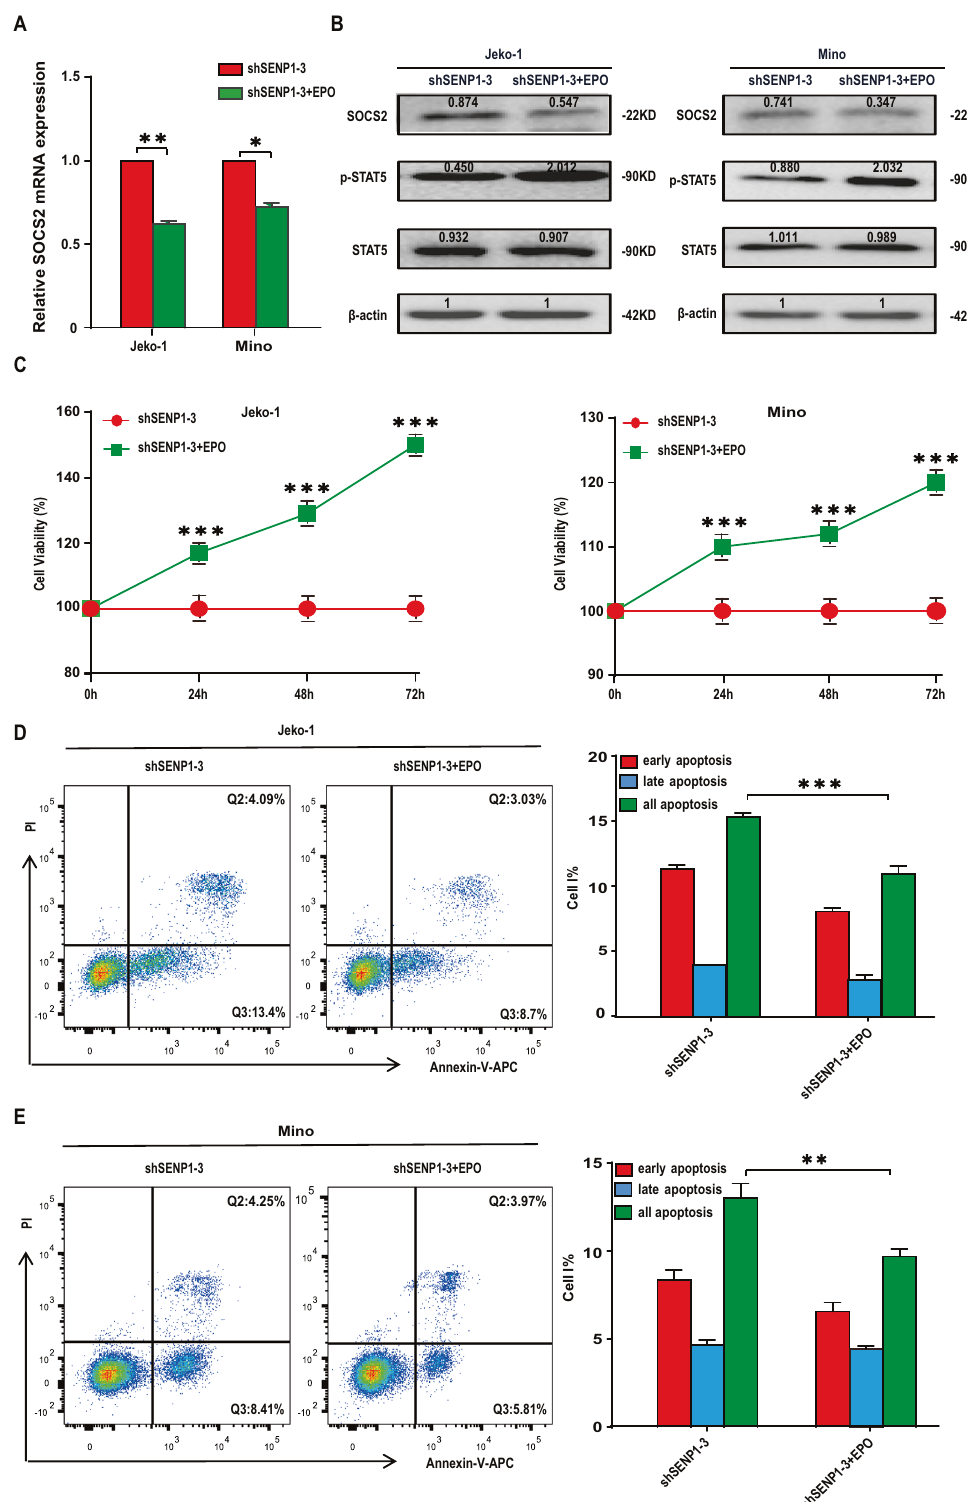
Fig. 5 Erythropoietin (EPO) rescues the effect of SENP1 knockdown on MCL cells. SOCS2 mRNA levels were detected by RT-qPCR ( A ), and the protein levels of SOCS2, p-STAT5 and STAT5 were detected by western blot ( B ) in shSENP1-3 transfected Jeko-1 and Mino cells after treated with EPO for 24 h. C The proliferation of shSENP1-3 transfected Jeko-1 and Mino cells was determined by CCK8 array after treated with EPO for 0 h, 24 h, 48 h or 72 h. The apoptosis of shSENP1-3 transfected Jeko-1 ( D ) and Mino ( E ) cells was measured by Annexin V-APC and PI double staining and fl ow cytometric analysis after treated with EPO for 48 h. Representative fl ow cytometry patterns from different groups were shown. Data were presented as mean ± SD and analyzed by two-sided Student ’ s t test. n = 3; ** P < 0.01, and *** P <